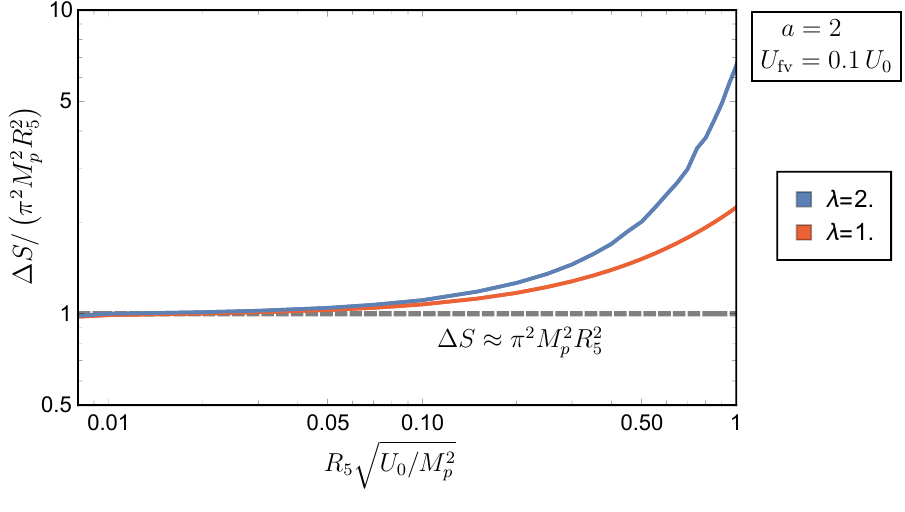
Figure 38: Action  S/ ⇡ 2 R 2 as function of R Figure 16 . The action ∆ S on the BON-FV branch for exponentially growing CC-dominated potentials, shown here normalized by a factor of π 2 M 2 small u 1 , the action remains well approximated by π 2 R 2 0 . become large as mR 1 5 &